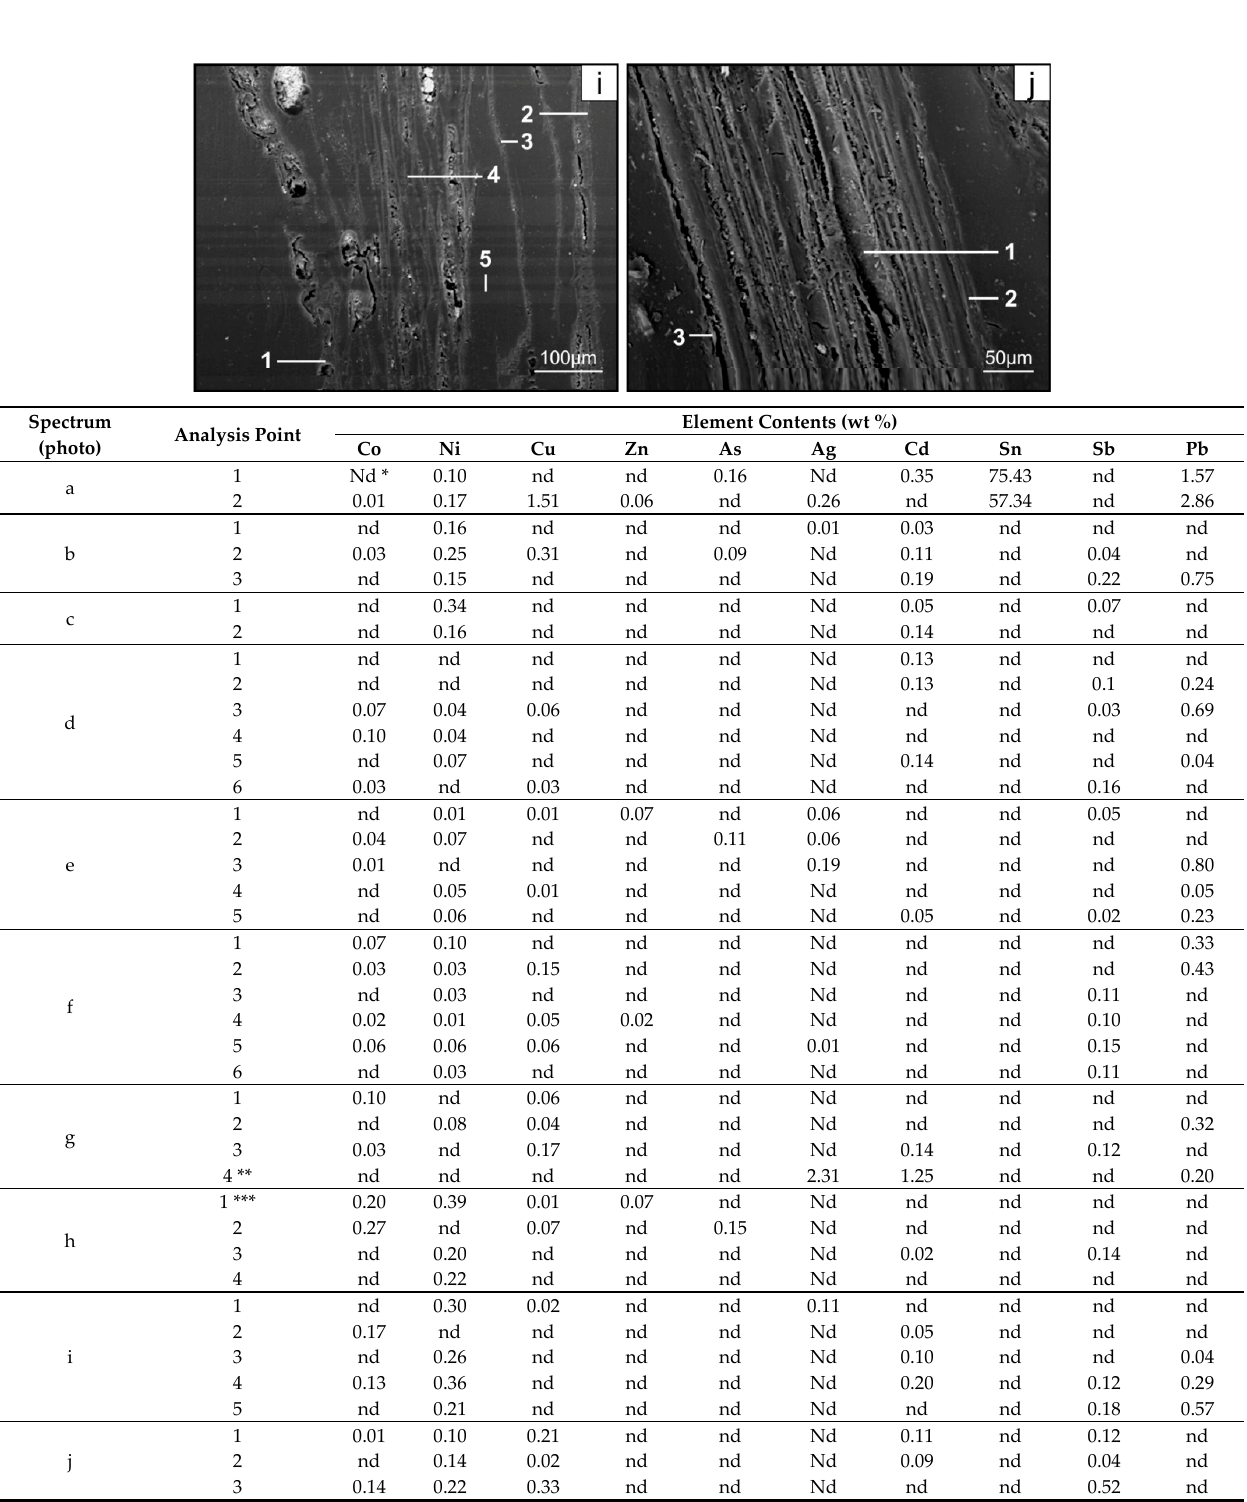
Figure 4. SEM/EDS trace element analysis (wt%) done on cross sections of the feed coal, fly ash, slag, topsoil, and root samples. ( a ) feed coal from PS-a: 1—cassiterite, 2—cassiterite with element inclusion, ( b ) feed coal from PS-c: 1—magnetite, 2—hematite, 3—Mg-siderite, ( c ) magnetic fraction of the fly ash >0.5 mm from PS-a: 1— magnetite dendrite on cenosphere, 2—plerosphere, ( d ) magnetic fraction of the slag from PS-b: 1—Fe-peryclase, 2—ferrosphere, 3—cenosphere, 4—cenosphere with magnetite inclusions, 5—Ca-Mg-ferrosphere, 6—magnetite on the Ca-Mg-ferrosphere, ( e ) magnetic fraction of the soil horizon B in area A: 1—magnetite sphere, 3—quartz with organic inclusion, 4—feldspar, 5—feldspar with organic inclusion, ( f ) magnetic fraction of the soil horizon Ah in area B: 1—wall of cenosphere, 2—cenosphere, 3—quartz,